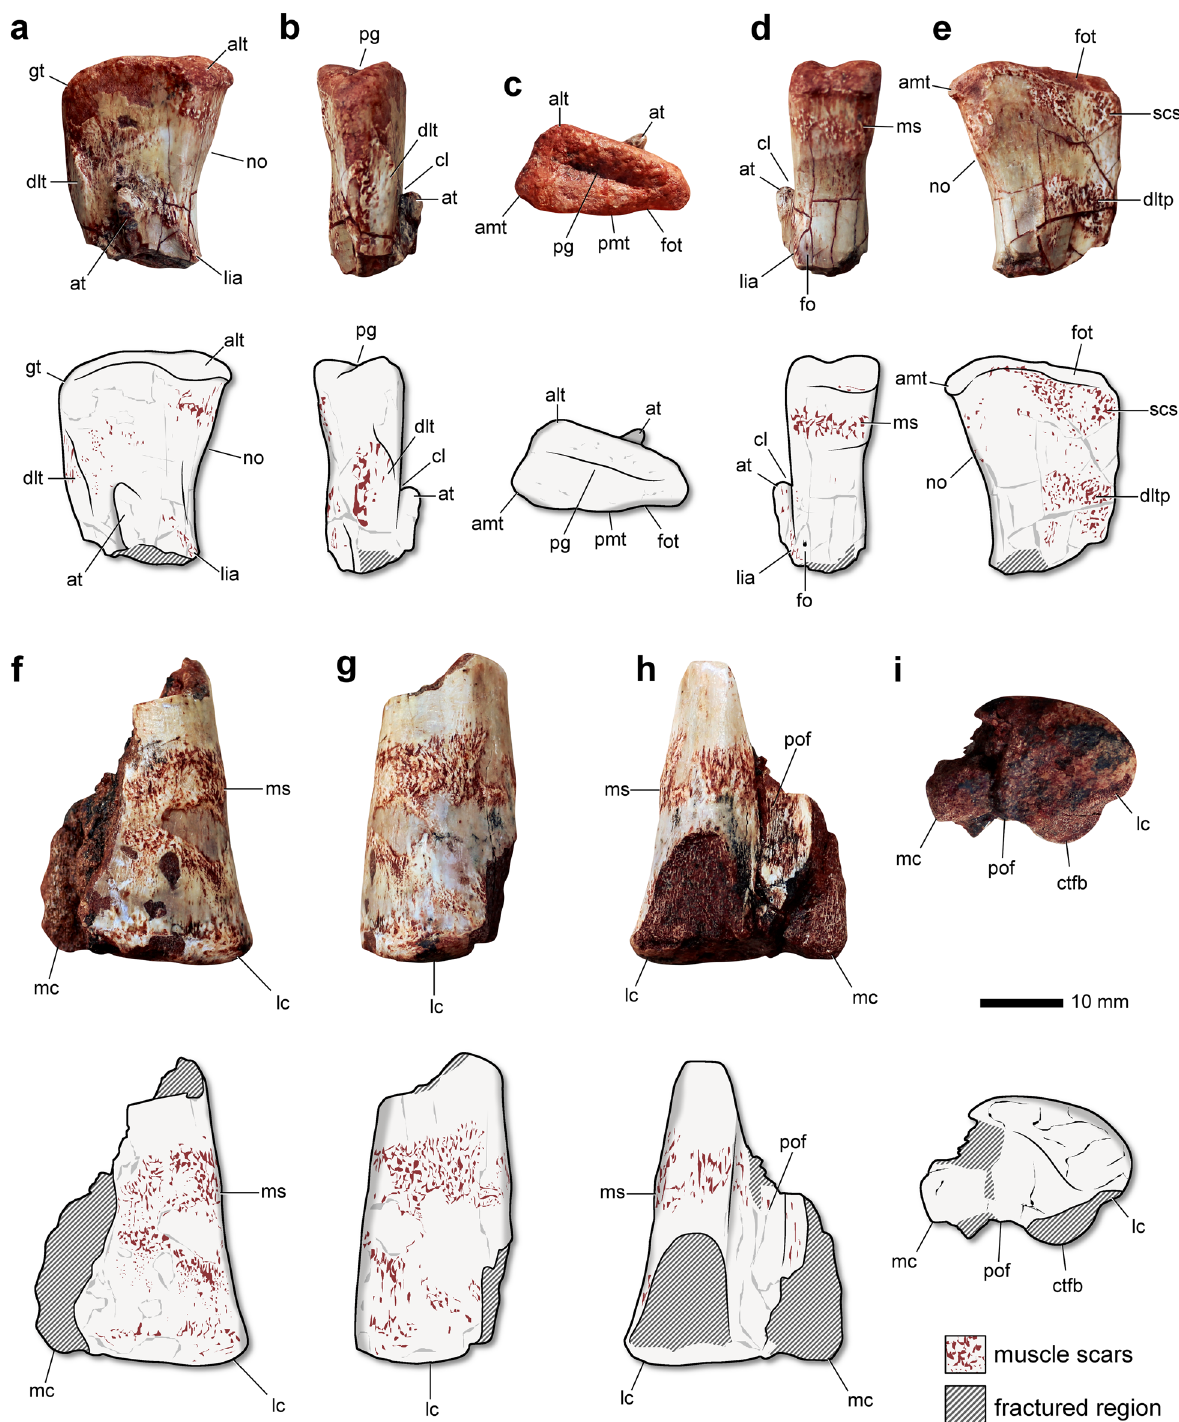
Figure 2. Holotype and referred specimen of Amanasaurus nesbitti gen. et sp. nov. from the Candelária Sequence (mid-to-late Carnian) of the Santa Maria Supersequence, southern Brazil. Holotype (CAPPA/ UFSM 0374) in anterior ( a ), lateral ( b ), proximal ( c ), medial ( d ), and posterior ( e ) views. Referred specimen (CAPPA/UFSM 0375) in anterior ( f ), lateral ( g ), posterior ( h ), and distal ( i ) views. alt anterolateral tuber, amt anteromedial tuber, at anterior trochanter, cl cleft, ctfb crista tibiofibularis, dlt dorsolateral trochanter, dltp posterior portion of the dorsolateral trochanter, fo foramen, fot fossa trochanterica, gt greater trochanter, lc lateral condyle, lia linea intermuscularis cranialis, mc medial condyle, ms muscle scar, no notch, pg proximal groove, pof popliteal fossa, scs sub-circular scar. Figures were generated with GIMP 2.8 (https:// www. gimp.